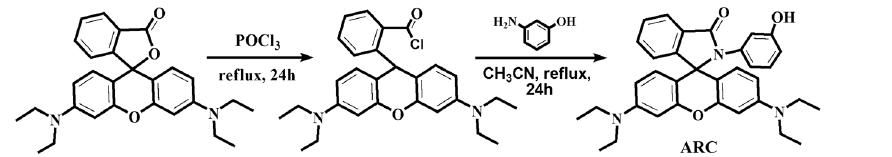
Figure 5. Synthesis of the chemosensor ARC